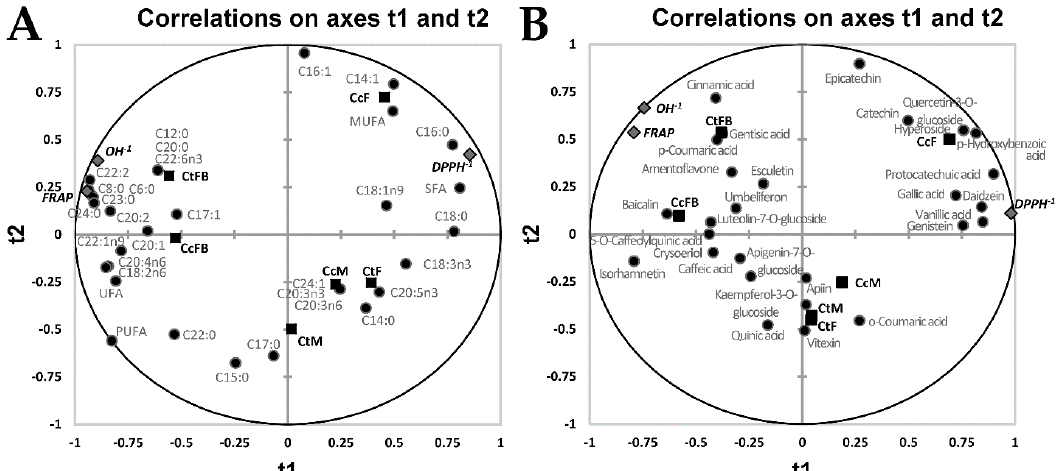
Figure 1. Partial least squares regression (PLSR) analysis for antioxidant potential. ( A )